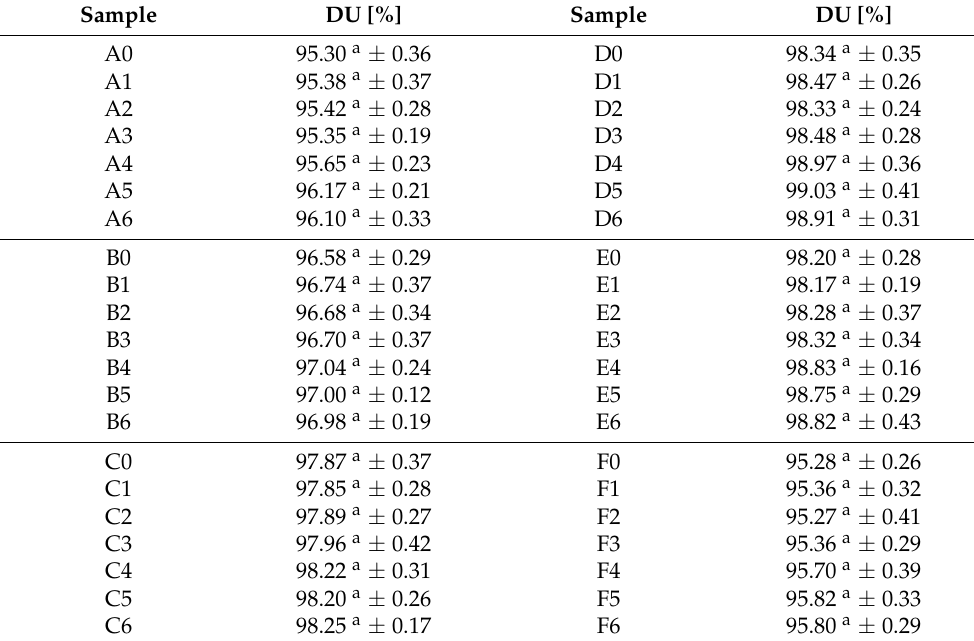
Table 2. Durability of pellets—unprocessed and treated with waste cooking oil, added by